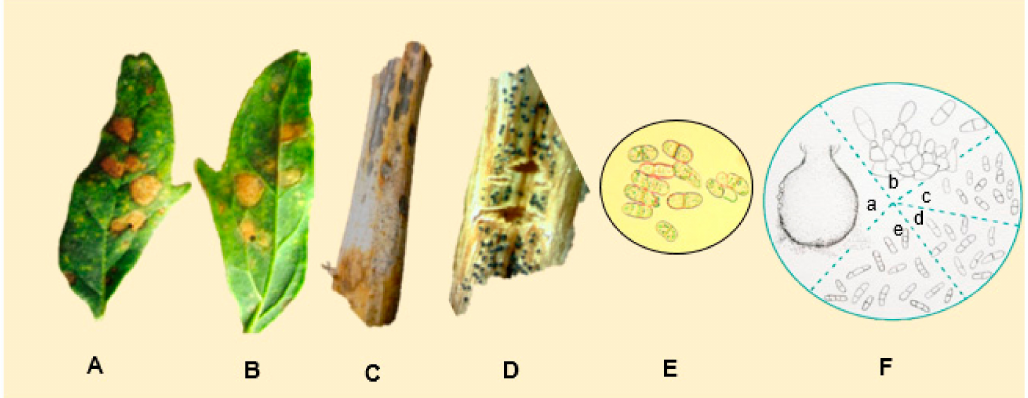
Figure 13. Leaves showing symptoms of infection caused by A. hyalospora ( A ) on the adaxial side of the leaf and ( B ) on the abaxial side. ( C ) Stems showing pycnidia and brown stalk. ( D ) Stem showing pycnidia. ( E ) A. hyalospora conidia (Photos: Testen, 2020) [77]. ( F ) A. hyalospora : ( a ) pycnidium ( × 200); ( b ) conidiogenous cells of pycnidium ( × 1000); ( c ) conidia from pycnidium ( × 400); ( d ) bi and tri-septate conidia from pycnidium on an inoculated stem of C. quinoa ( × 400); ( e ) conidia from pycnidium on leafspot of inoculated leaf of C.quinoa ( × 400). Source: photos ( A − E ) provided by A.L. Testen. F. Adapted from